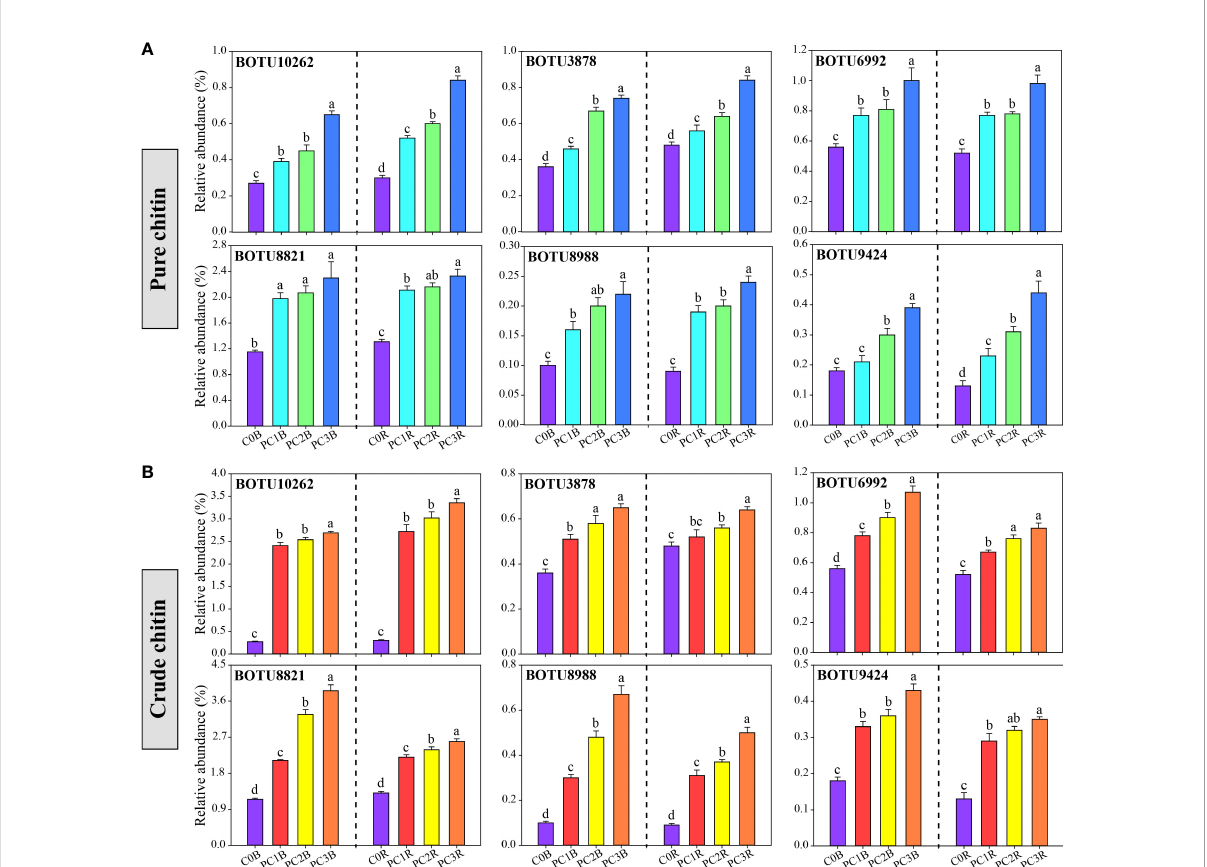
FIGURE 3 Relative abundance of potentially bene fi cial bacteria under different pure (A) and crude (B) chitin addition dosages. The bars indicate the means of 8 replicates and the error bars represent the standard deviation. Different letters indicate signi fi cant differences among treatments (one-way ANOVA, P < 0.05, Duncan ’ s multiple-range test). The treatment description is same as Figure